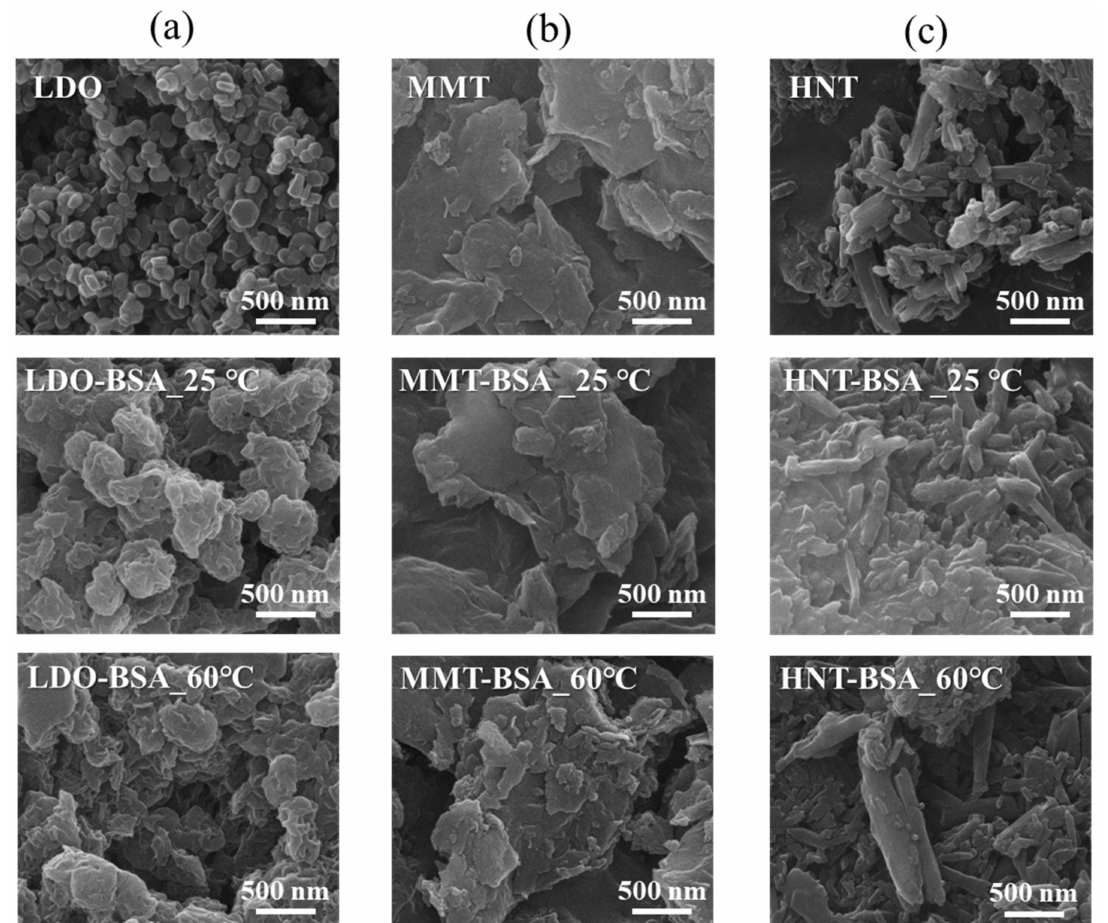
Figure 2. Scanning electron microscope image of ( a ) LDO, ( b ) MMT and ( c ) HNT with bovine serum albumin at 25 ◦ C and 60 ◦